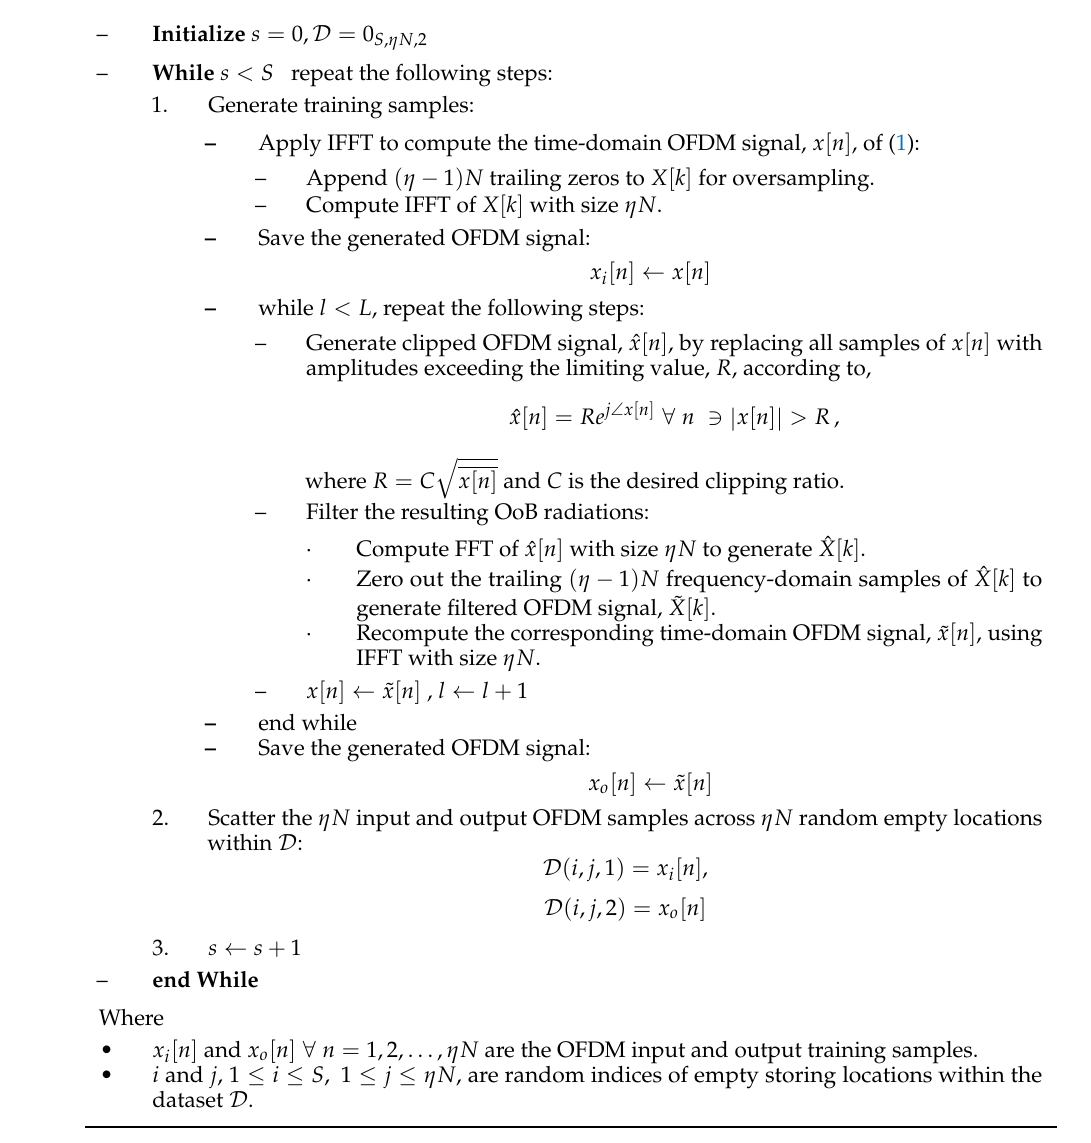
Algorithm 1 Proposed Dataset